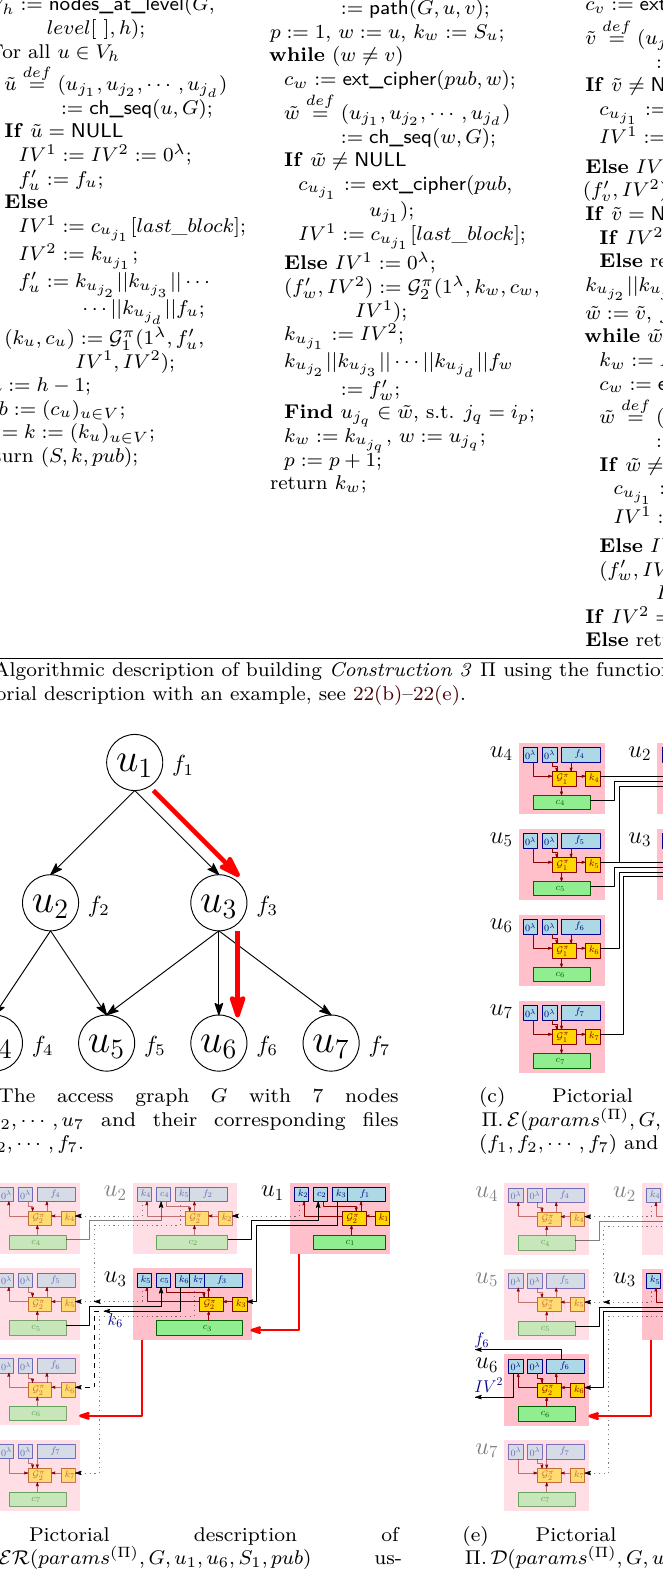
Pictorial description of Π . DER ( params (Π) ,G,u 1 ,u 6 ,S 1 ,pub ) using the path ( u 1 ,u 3 ,u 6 ) which is shown in red line in graph G in 22(b). Figure 22: Building Construction 3